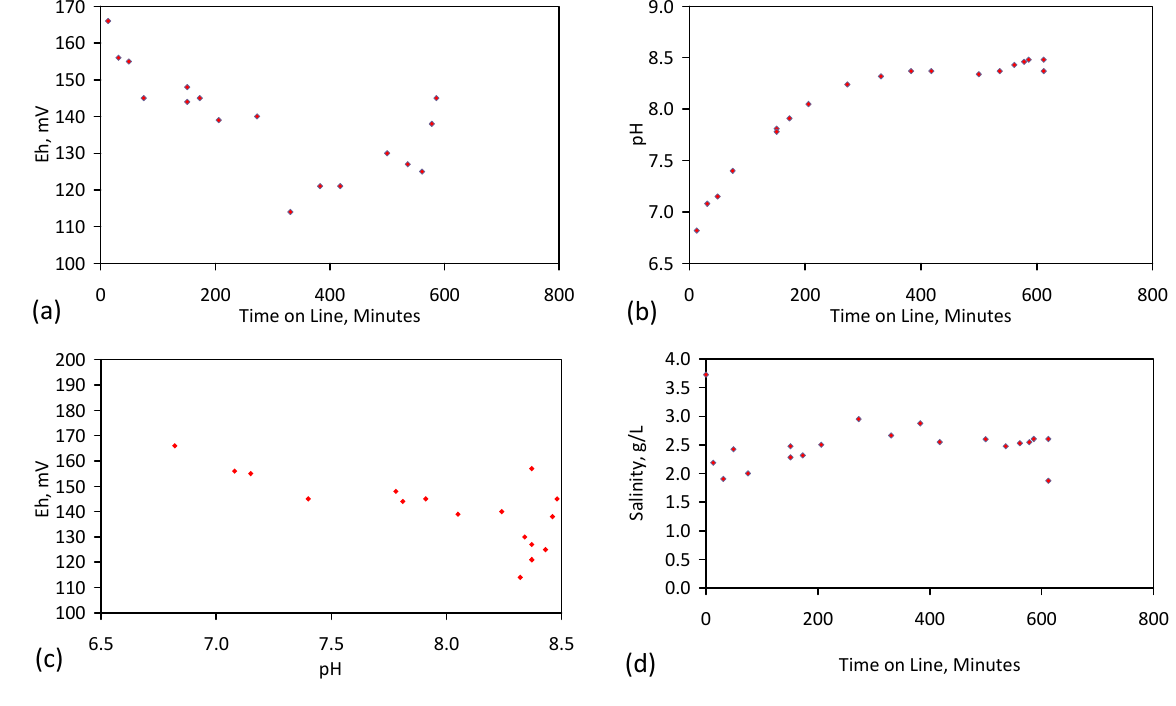
Figure C26. ZVM TPA example Trial E146. 6th Reuse; Operating Temperature: 19–25 °C; Oxidising Environment: Water volume in the reactor = 0.24 m 3 ; ZVM TPA from Trial E145 in a cartridge = 0.4 kg; Air flow = 120 L·h − 1 . ( a ) Eh vs. time; ( b ) pH vs. time; ( c ) pH vs. Eh; ( d ) Salinity vs. time; ( e ) Salinity calculated from normalised data vs. salinity calculated from raw data; ( f ) EC vs.